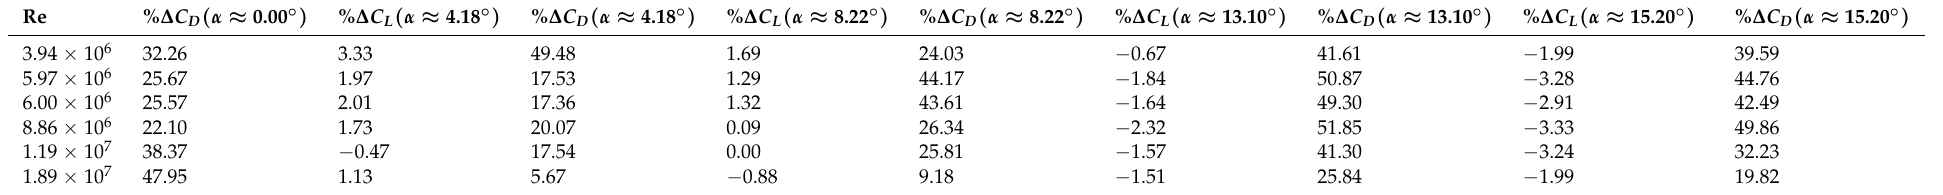
Table 4. Comparison of results of hydrodynamic coefficients under different Re with that of experimental benchmark data adopted from [25] in relative